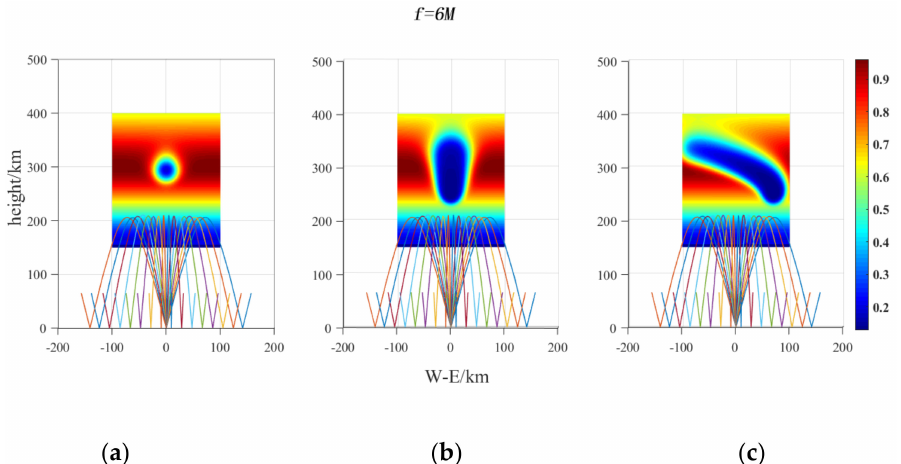
Figure 8. 3D ray-tracing simulation of 6 MHz short wave propagation path after 100 s of H 2 O released by rocket under different flight paths (electron density unit: 10 6 cm − 3 ); ( a ) 300 km fixed − point release, ( b ) 250 − 350 km vertical path, ( c ) 250 − 350 km parabolic path.